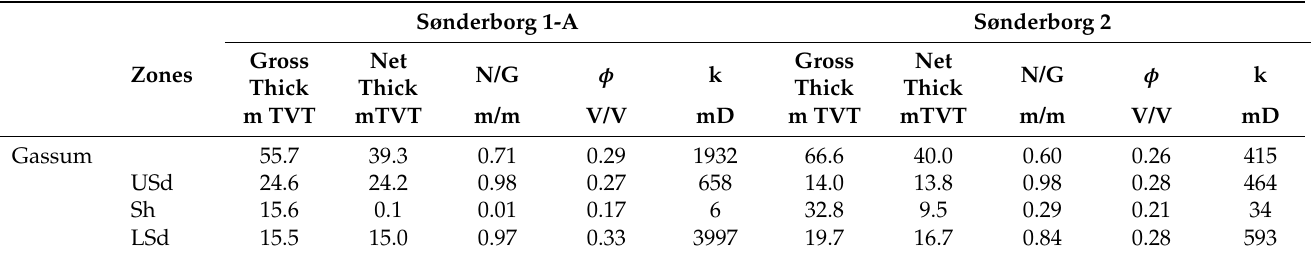
Table 1. Gassum formation net average